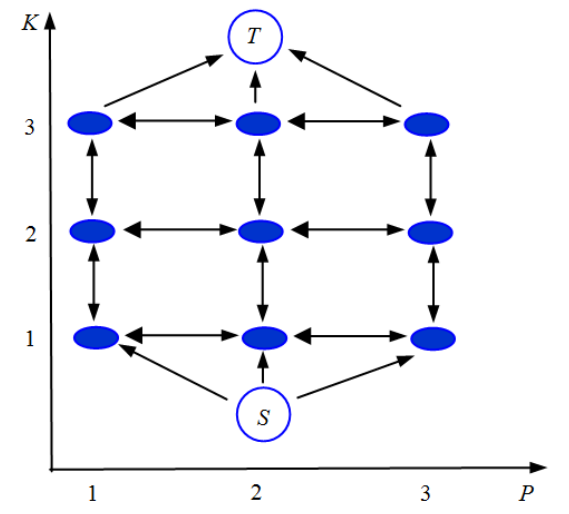
Figure 2. One dimensional Ishikawa graph construction: circles represent the vertexes V , arrows represent the edges E